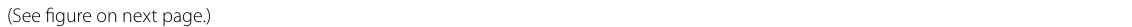
figure on next Fig. 4 Light micrographs of embryo development of A. roxburghii at the early stages. a Light micrograph of a mature embryo sac before fertilization at 5 DAP. The egg cell (E) has an elongated shape with a prominent vacuole toward the micropylar end. Antipodal cells (arrowheads), inner seed coat (IS), outer seed coat (OS), polar nucleus (arrow), synergid (S). Scale bar 30 µm. b Light micrograph of the zygote (Z) after fertilization at 10 = DAP. At the micropylar end, one synergid has degenerated (DS), and the other synergid is still persistent (PS). The primary endosperm nucleus (arrow) could be observed within the endosperm cavity, but the endosperm eventually fails to develop. Antipodal cells (arrowheads), inner seed coat (IS), outer seed coat (OS). Scale bar 30 µm. c An elongated zygote (double arrowhead) with a prominent vacuole (V) toward the micropylar = end. No additional division of the endosperm nucleus (arrow) is observed. Inner seed coat (IS), outer seed coat (OS). Scale bar 30 µm. d The first = cell division of the zygote produces a smaller terminal cell (T) and a larger basal cell (B). Inner seed coat (IS), outer seed coat (OS). Scale bar 30 µm. = e Light micrograph showing a three‑celled embryo (arrowheads), and the endosperm nucleus (arrows) has become condensed. Inner seed coat (IS), outer seed coat (OS). Scale bar 30 µm. f The alignment of metaphase chromosomes (arrow) indicates a transverse division occurring in = the basal cell of a three‑celled embryo. Inner seed coat (IS), outer seed coat (OS). Scale bar 30 µm. g A four‑celled embryo resulting from the = transverse division of the basal cell. The cell towards the micropylar end has become larger with a prominent nucleus and numerous small vacuoles (arrows). The cell accumulates numerous small vacuoles in preparation for the further cell elongation. Inner seed coat (IS), outer seed coat (OS). Scale bar 30 µm. h Light micrograph showing a filamentous‑shaped embryo. The suspensor cell (S) with a prominent vacuole has enlarged and = elongated toward the micropylar end. A few tiny starch granules (arrowheads) are present in the suspensor cell. Inner seed coat (IS), outer seed coat (OS). Scale bar 30 µm. i The suspensor cell (S) elongates rapidly with numerous starch granules (arrowheads) and has protruded into the cavity = enclosed by the outer seed coat (OS). At this stage, the inner seed coat (IS) is degenerating (arrow). Scale bar 30 =